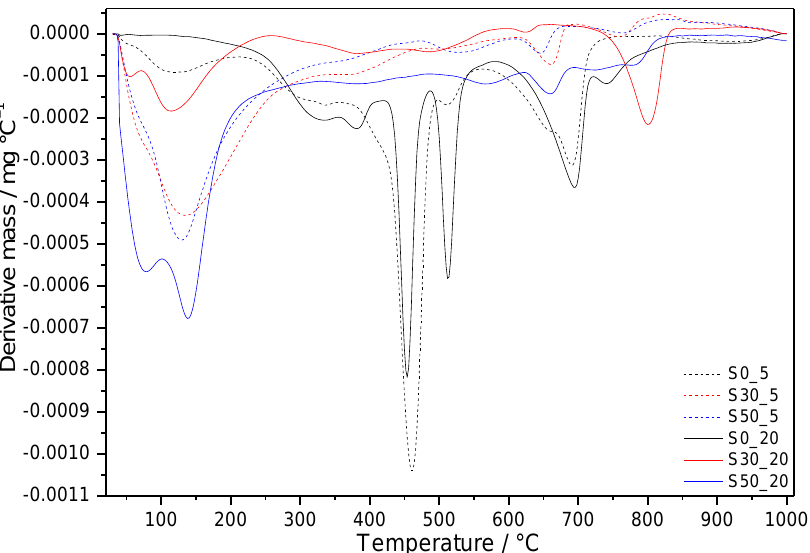
Figure 7. DTG curves of samples with ( a ) 30 mass% SF and ( b ) 50 mass% SF addition after 7 days of hydrothermal curing.